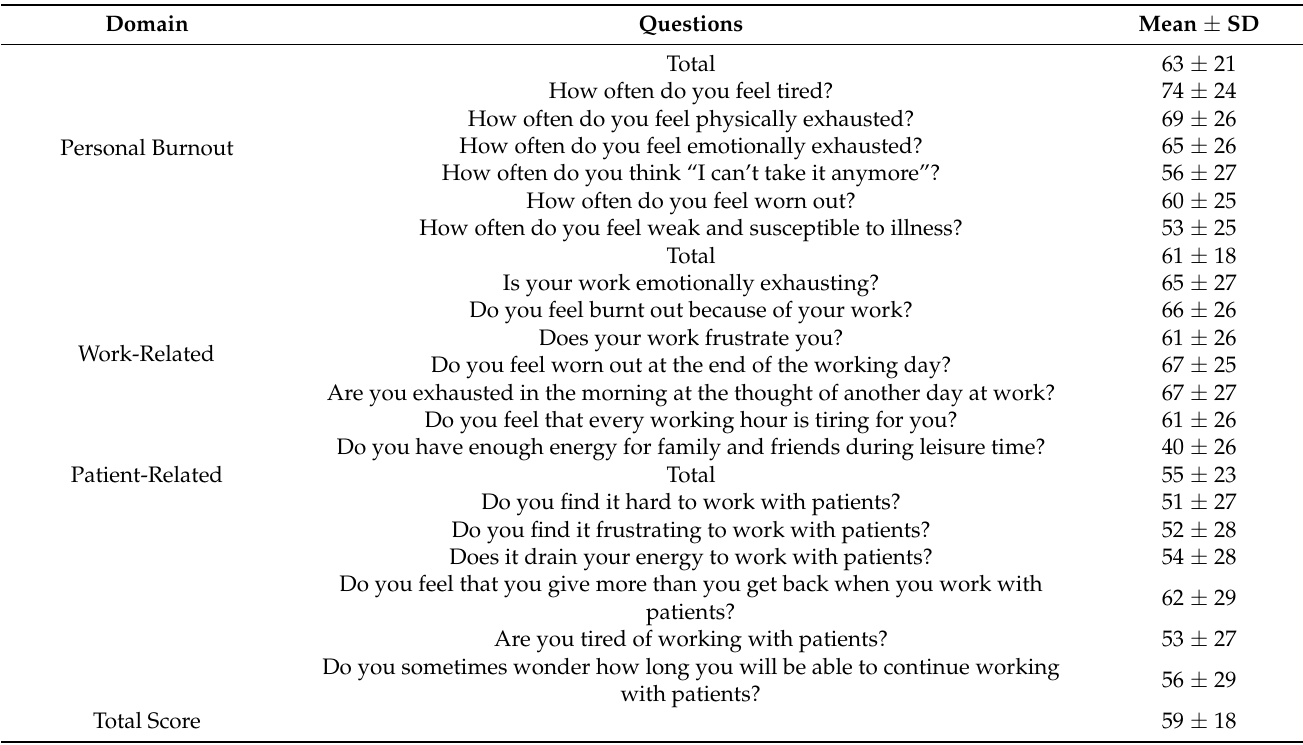
Table 2. The responses of 502 residents to CBI items.